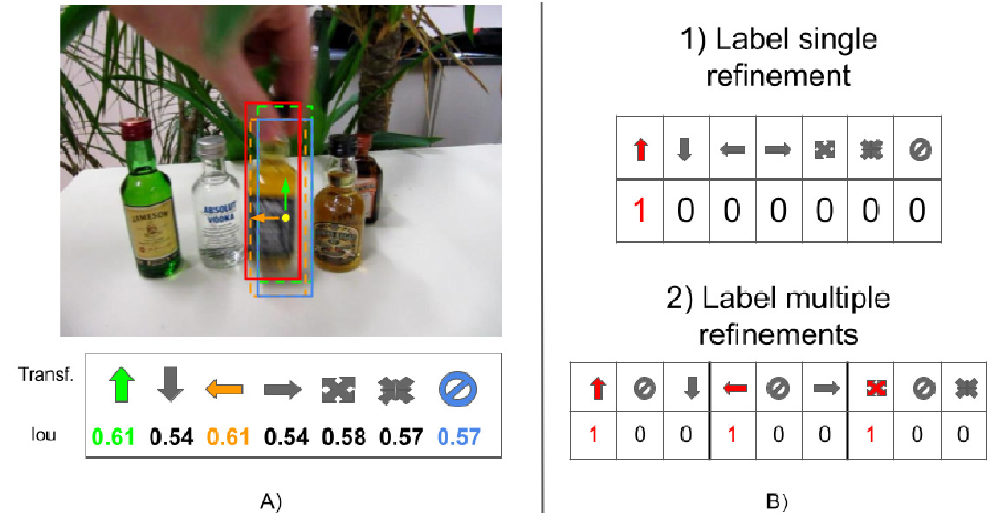
Figure 2. Image ( A ) shows the IoU values calculated after each of the possible refinements. Im- age ( B ) shows how 1-hot-encoding is used to annotate the data in single and multiple bounding box